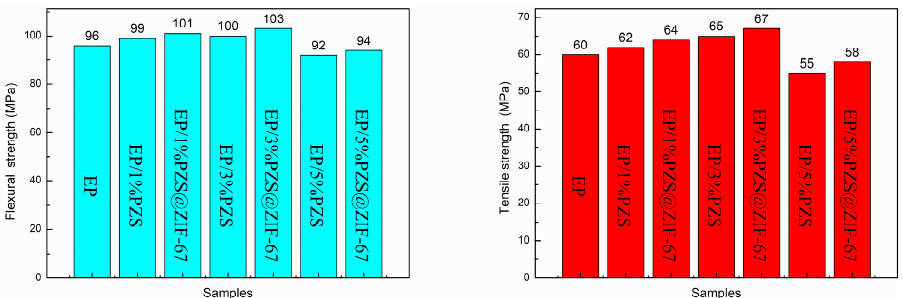
Figure 13. Flexural and tensile strength of EP and its composites.